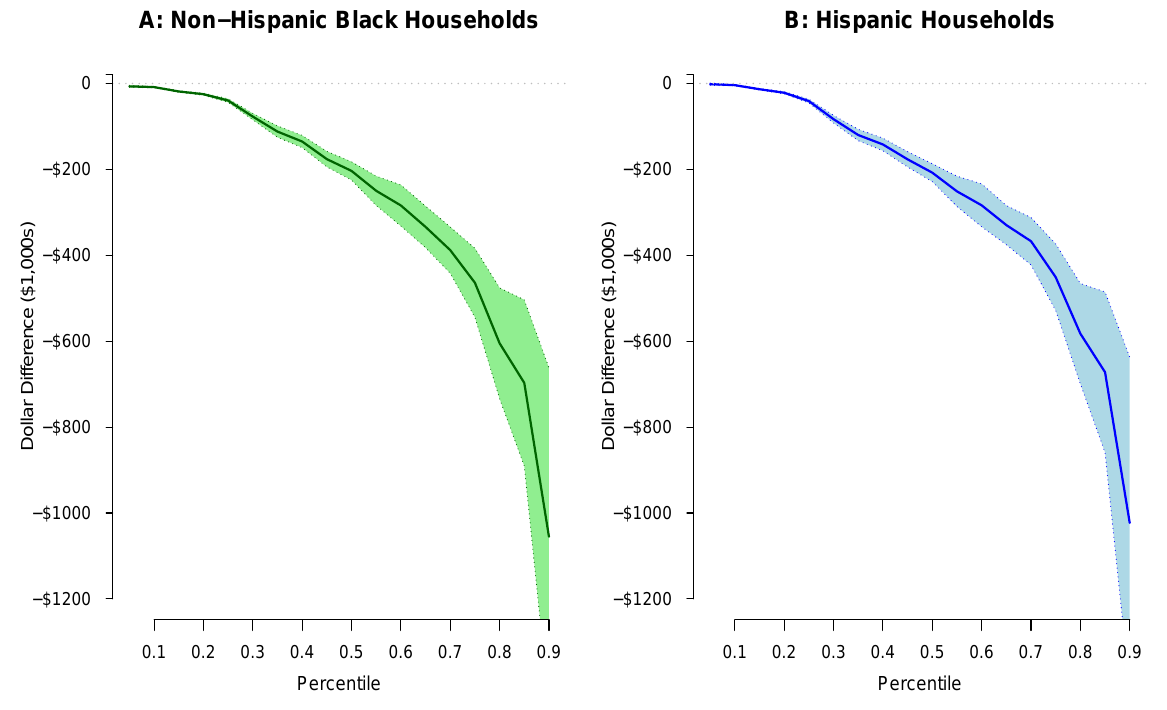
Figure 2: Difference in net worth by race, ethnicity, and percentile, 1998–2013, no controls. Notes: Figure 2 presents the unconditional difference in net worth across the distribution for non-Hispanic black households (Panel A) and Hispanic households (Panel B) when compared to non-Hispanic white households in 2013 U.S dollars. The figure includes estimates and 95 percent confidence intervals. Models also account for